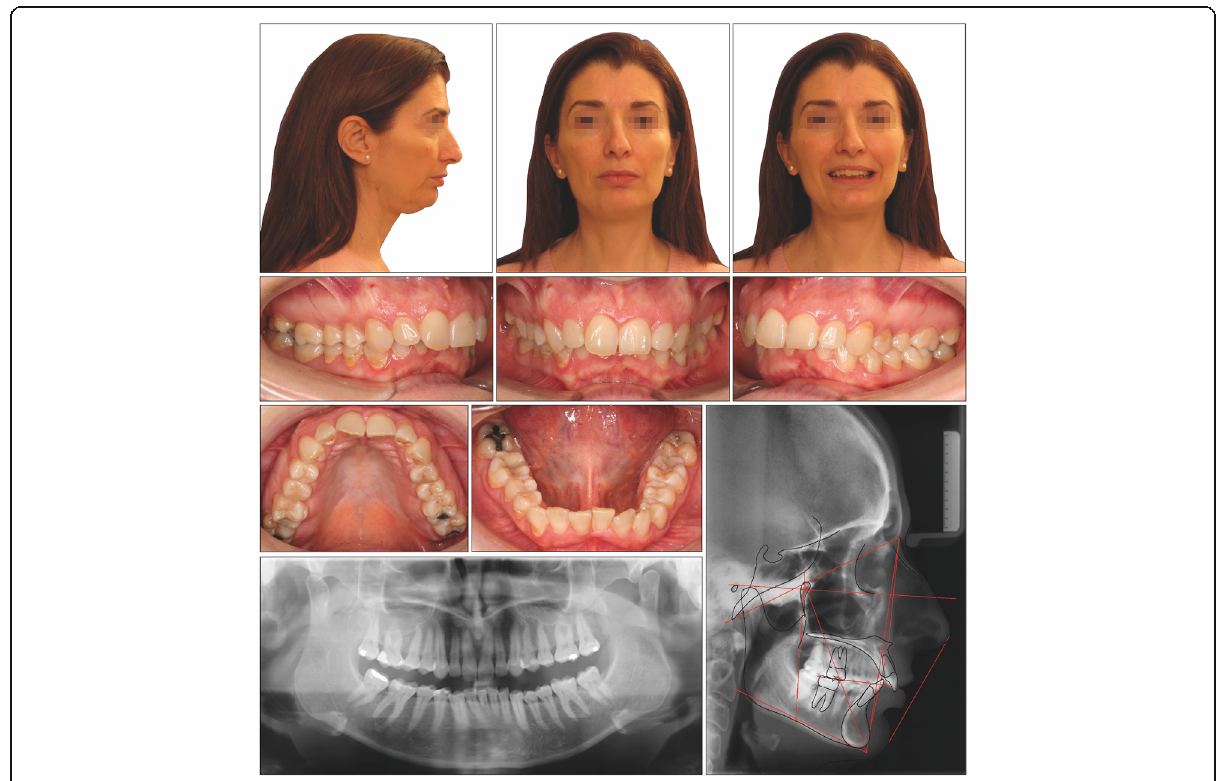
Fig. 1 Pretreatment records of patient